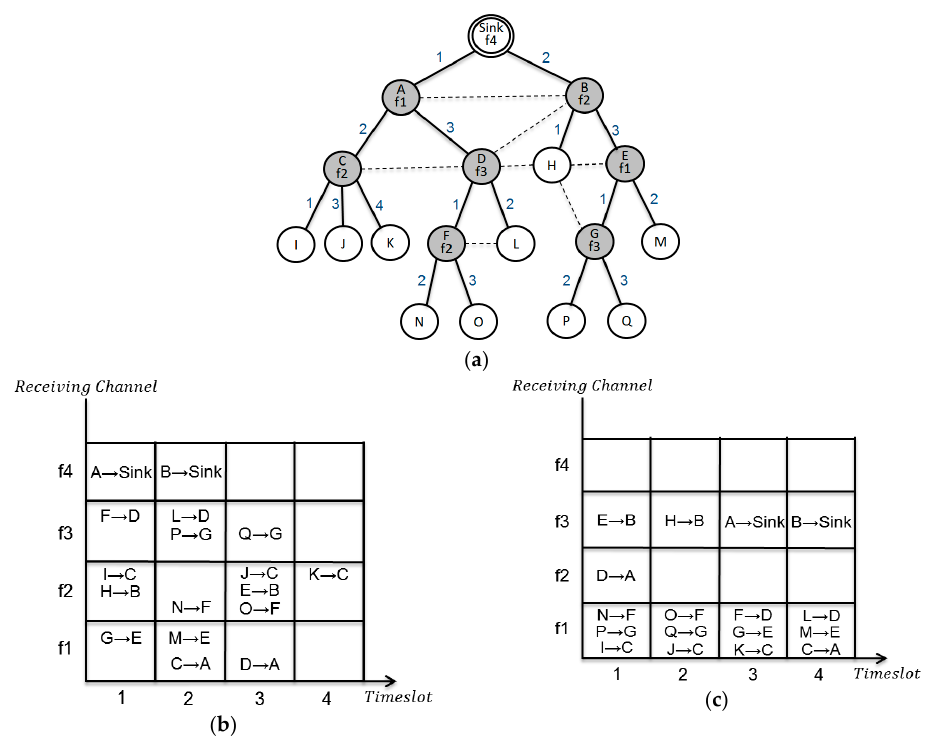
Figure 4. Example: channel and time slot scheduling between the LDF and the proposed scheme: ( a ) channel and time slot scheduling by the LDF; ( b ) channel and time slot scheduling table of Figure 4a; and ( c ) channel and time slot scheduling table of Figure 2c.